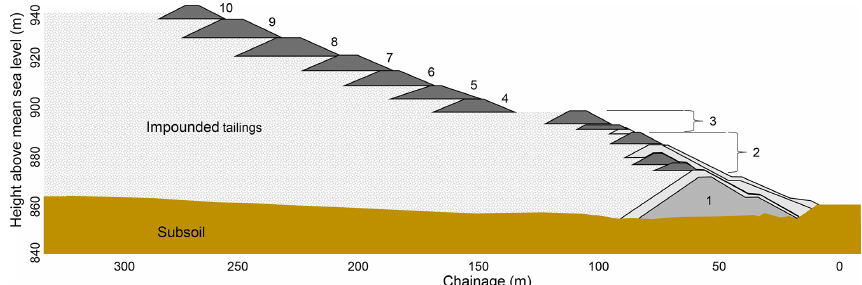
Figure 2. Cross section of the Brumadinho tailings dam and the stages in which it was raised (source: adapted from Robertson et al., 2019).